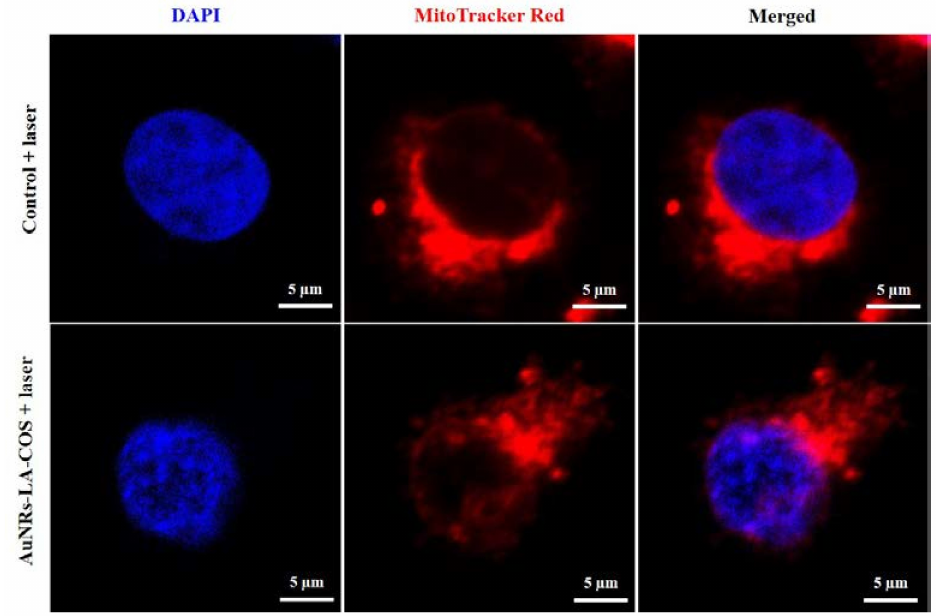
Figure 6. Confocal fluorescence microscope images stained by DAPI and MitoTracker Red. Confocal fluorescence microscope image of MDA-MB-231 cells treated without or with 25 µ g/mL AuNRs-LA-COS and irradiated with 808 nm NIR laser at 2 W/cm 2 for 5